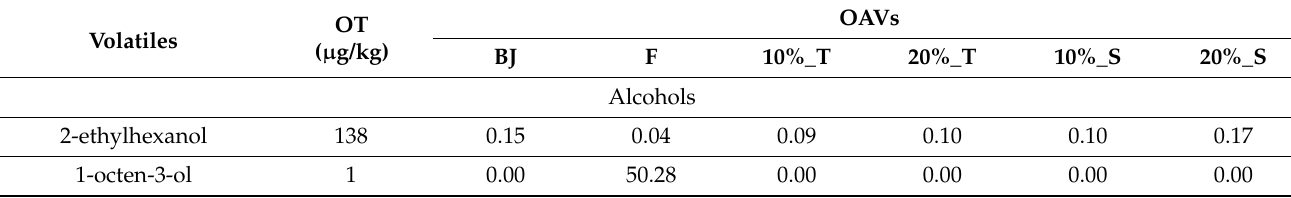
Table 4. Odor activity values (OAVs) of blackberry juice, citrus fiber and citrus fiber/blackberry gels after preparation.